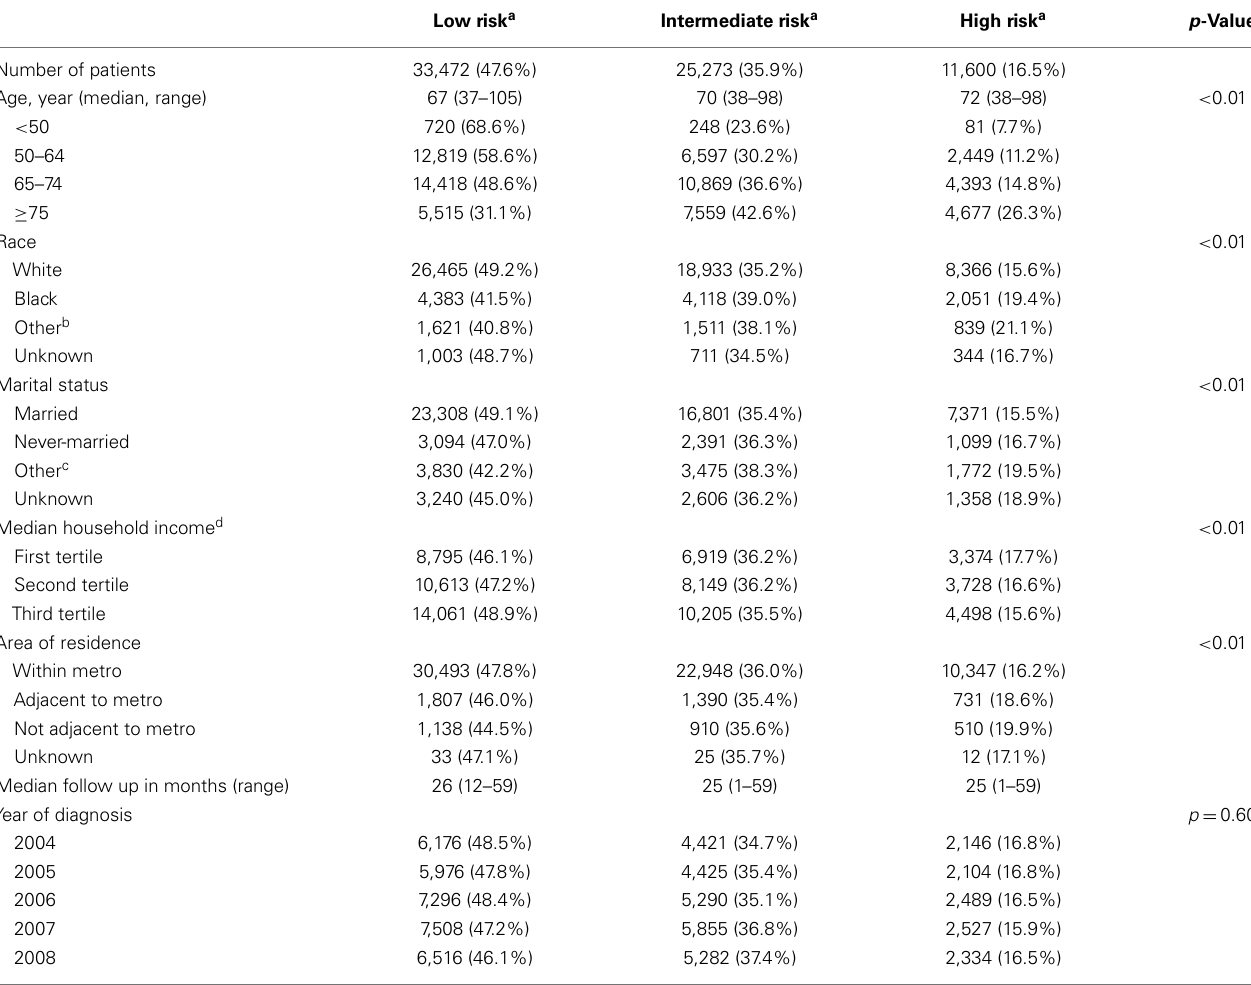
Table 2 | Characteristics of 70,345 men with low-, intermediate-, and high-risk prostate cancer . Low risk